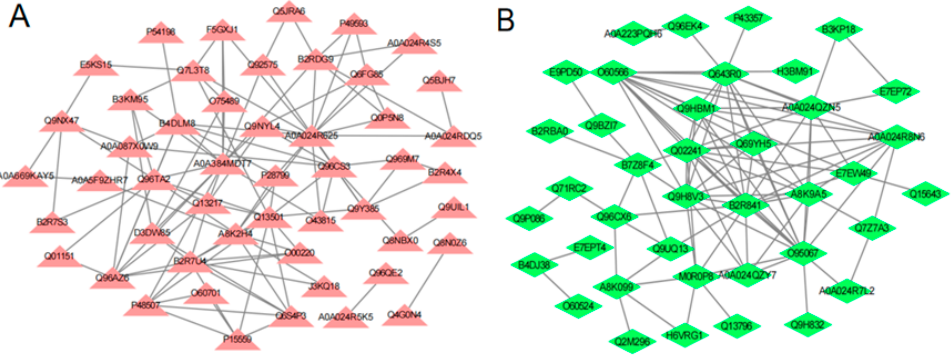
Figure 3. Interaction of differential proteins: ( A ) interaction diagram of differentially up-regulated proteins; ( B ) interaction diagram of differentially down-regulated proteins. The triangles or diamonds represent proteins, straight lines represent the interaction relationship between